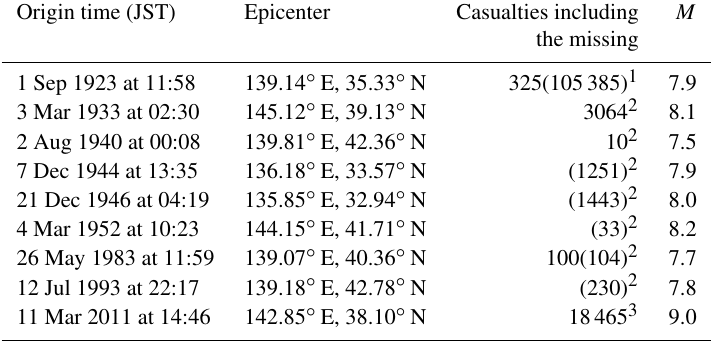
Table 1. Major disastrous earthquakes and casualties due to their tsunami around the Japanese islands in the past 100 years. Origin time (JST) Epicenter